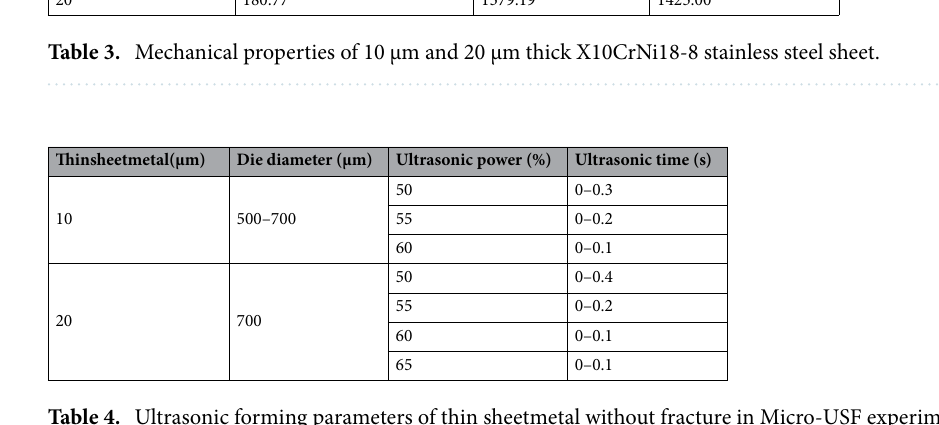
Table 4. Ultrasonic forming parameters of thin sheetmetal without fracture in Micro-USF experiment.